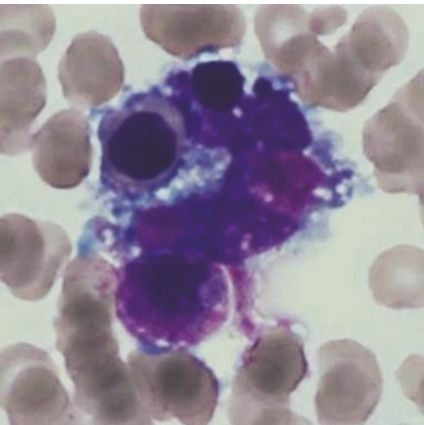
Figure 1: Bone marrow biopsy demonstrating a macrophage con- taining a late stage erythroid precursor compatible with hemopha-